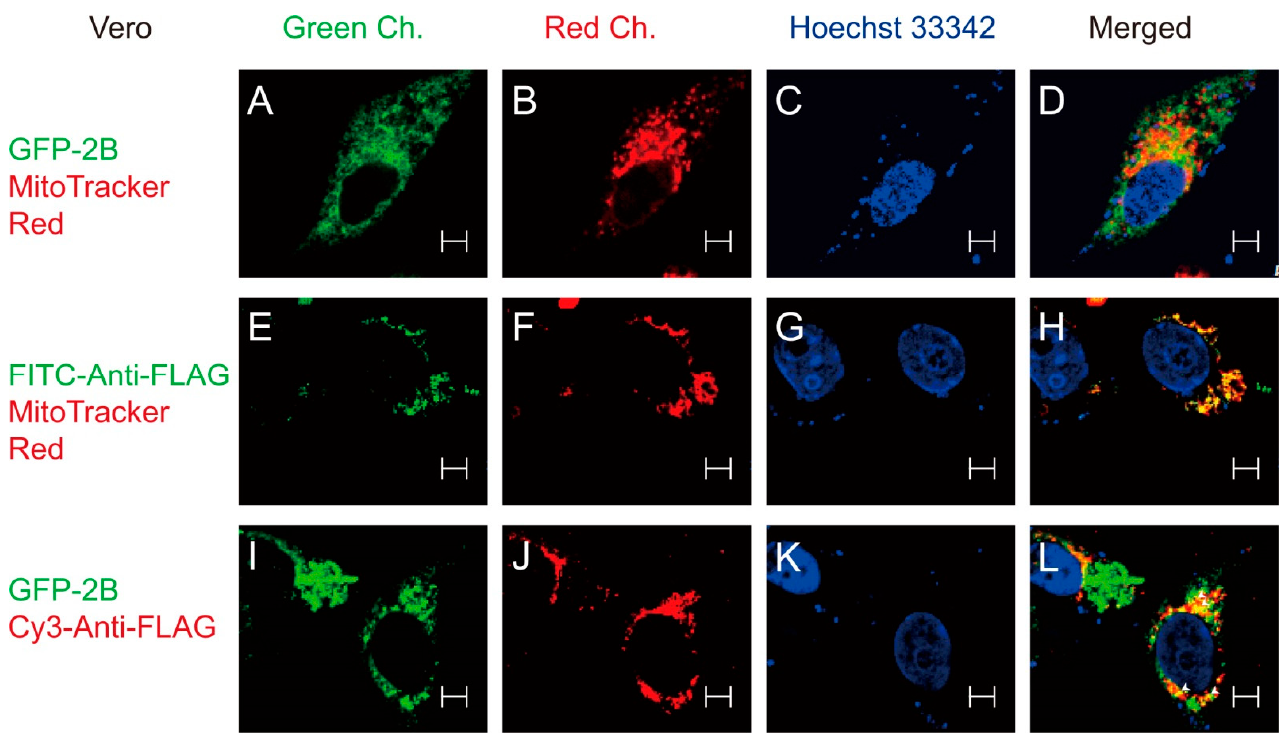
Figure 4. Localization of 2B and VDAC3 to the periphery of mitochondria. ( A – D ) Vero cells were transfected with the GFP ‐ 2B expression vector, and stained with MitoTracker Red and Hoechst dye 33342 at 24 h post ‐ transfection. They were counterstained with Hoechst 33342. The samples were processed for confocal microscopic examination of 2B ( Green Channel ), mitochondria ( Red Channel ), and nuclei ( Hoechst 33342 ). The images are overlaid ( Merged ). ( E – H ) Vero cells were transfected with N ‐ FLAG ‐ VDAC3 expression vector, and stained with FITC ‐ conjugated anti ‐ FLAG antibody and MitoTracker Red at 24 h post ‐ transfection. They were counterstained with Hoechst 33342. The samples were processed for confocal microscopic examination of FITC ‐ conjugated anti ‐ FLAG antibody ‐ bound VDAC3 ( Green Channel ), mitochondria ( Red Channel ), and nuclei ( Hoechst 33342 ). The images are overlaid ( Merged ). ( I – L ) Vero cells were transfected with GFP ‐ 2B and N ‐ FLAG ‐ VDAC3 expression vectors, and stained with Cy3 ‐ conjugated anti ‐ FLAG antibody at 24 h post ‐ transfection. They were counterstained with Hoechst 33342. The samples were processed for confocal microscopic examination of 2B ( Green Channel ), VDAC3 ( Red Channel ), and nuclei ( Hoechst 33342 ). The white arrowheads indicate the specific locations at which 2B and VDAC3 bind. The images are overlaid ( Merged ). A representative result of three experiments is shown here. Scale bar = 5 μ m.